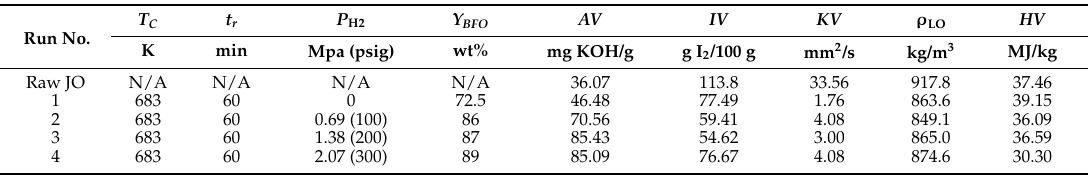
(HTC) at various P H2 .